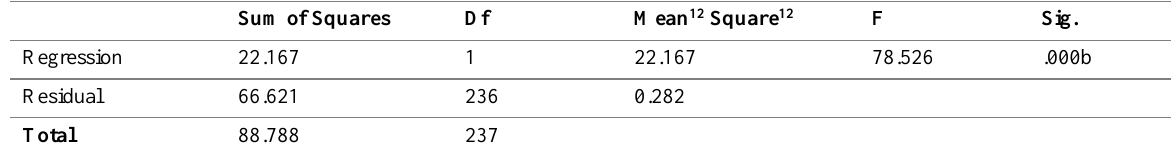
Table 7: ANOVA for gambling severity and economic wellbeing